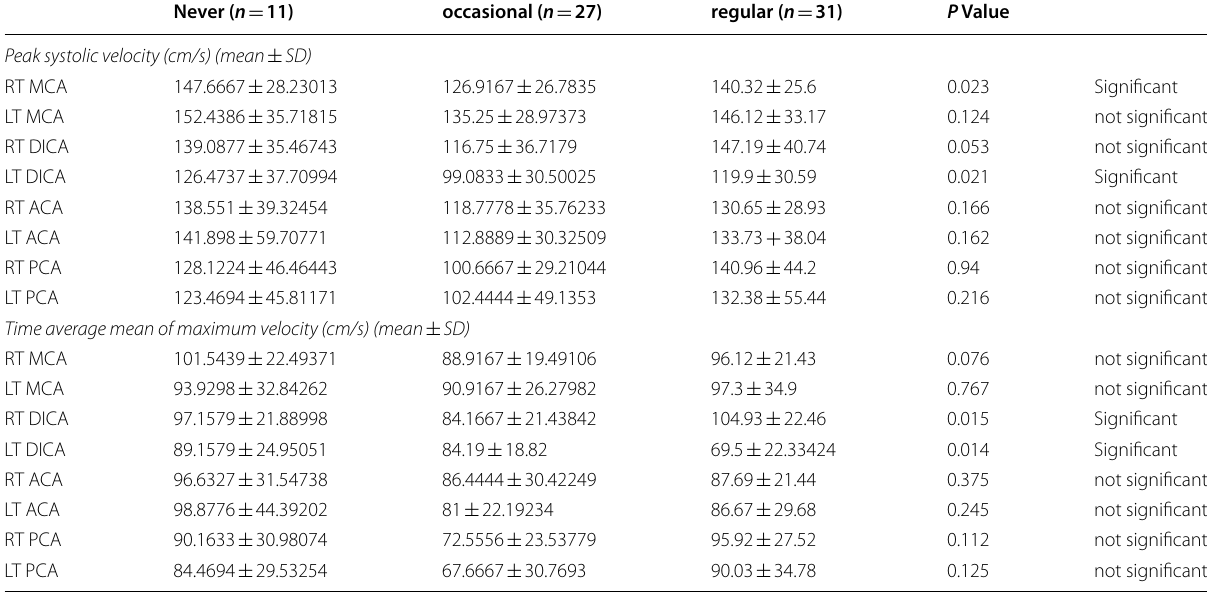
Table 3 Comparison between groups according to frequency of blood transfusion regarding demographic, hematological, biochemical and radiological parameters